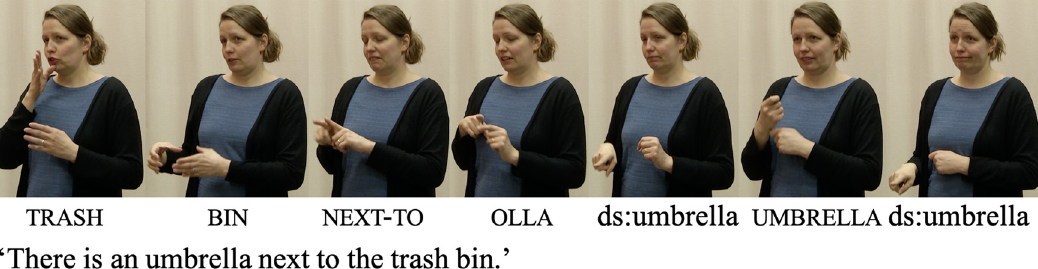
Figure 14: An example of a sequential strategy including an adposition sign and a new Figure entity depicted on H1.